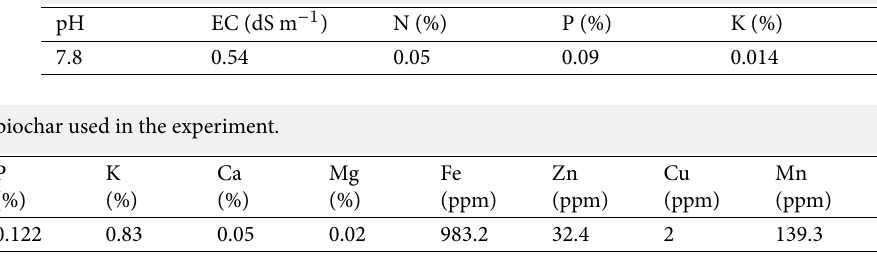
Table 1 Some chemical properties of the farm soil.